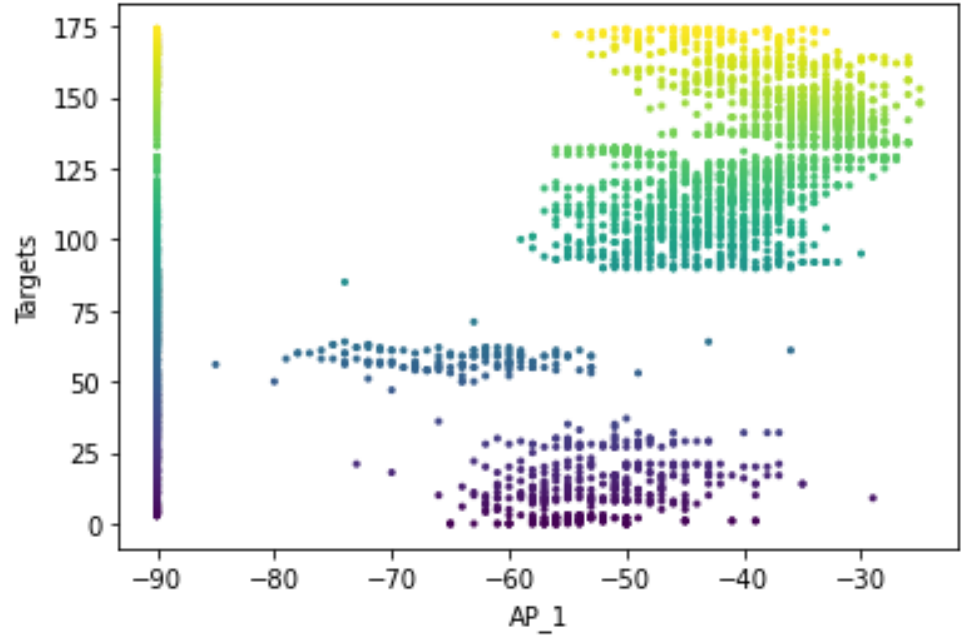
Figure 16. Distributions of RSS for Wi-Fi-AP1 with their corresponding Targets for dataset B.